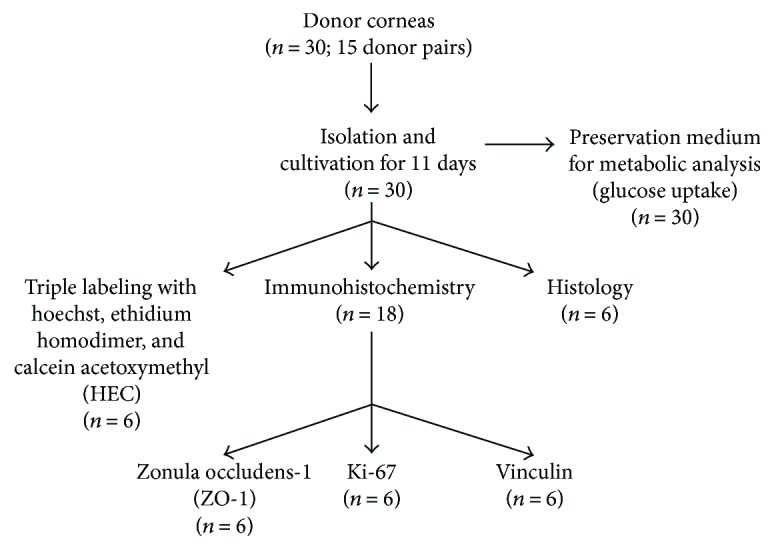
An overview of the performed experiments with the amount of corneal donor pairs used in each group.